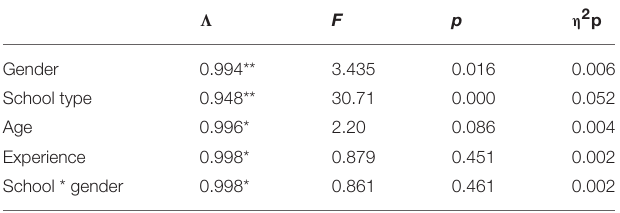
TABLE 2 | Multivariate